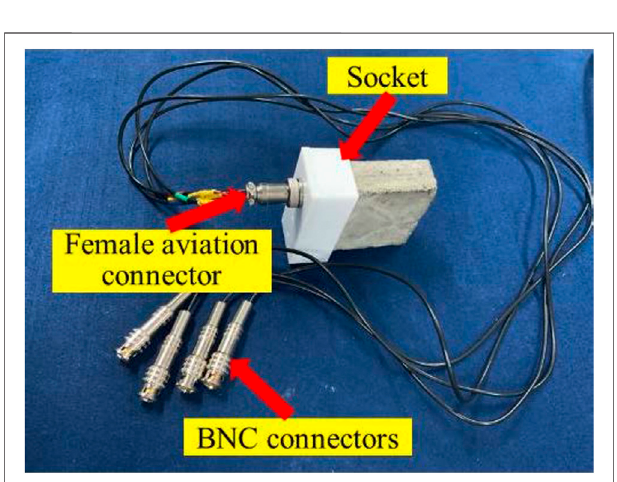
FIGURE 3 | Fabricated CIM model.